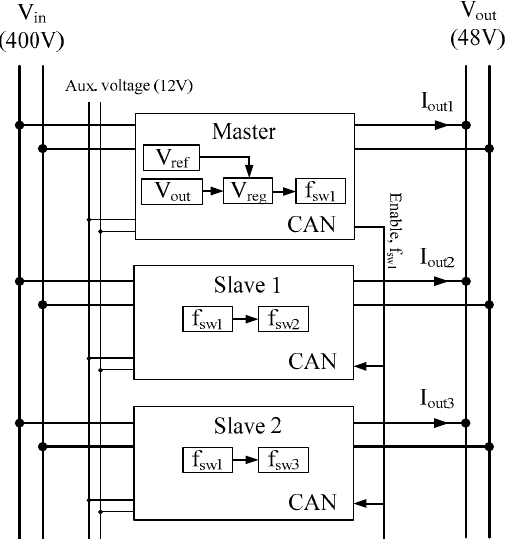
Figure 8. Block diagram of the control strategy proposal for MAPS based on the frequency follower.